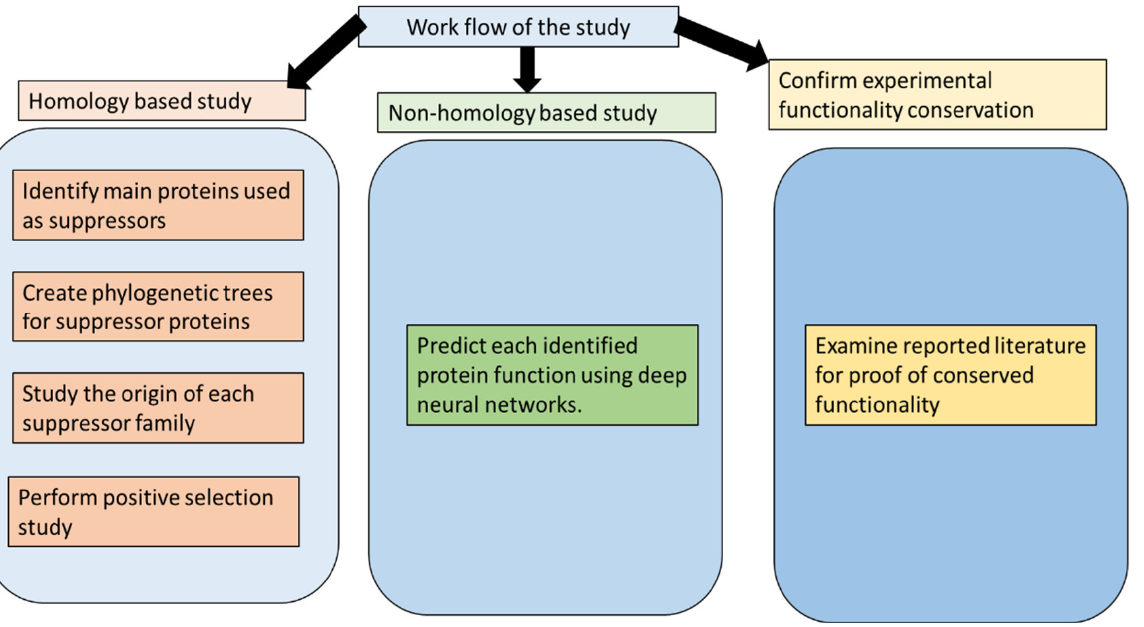
Figure 1. Workflow of the study. We approached the problem of investigating conserved Treg suppression pathways through three different pathways: (i) Homology based, in which we followed classical phylogenetic analysis procedures. (ii) Non-homology-based approach, where we utilized artificial intelligence to predict the function of the identified proteins. (iii) In order to increase the accuracy of our estimations, we compared our predictions with published reports that experimentally validated functional conservation of Treg suppressor proteins among different species.